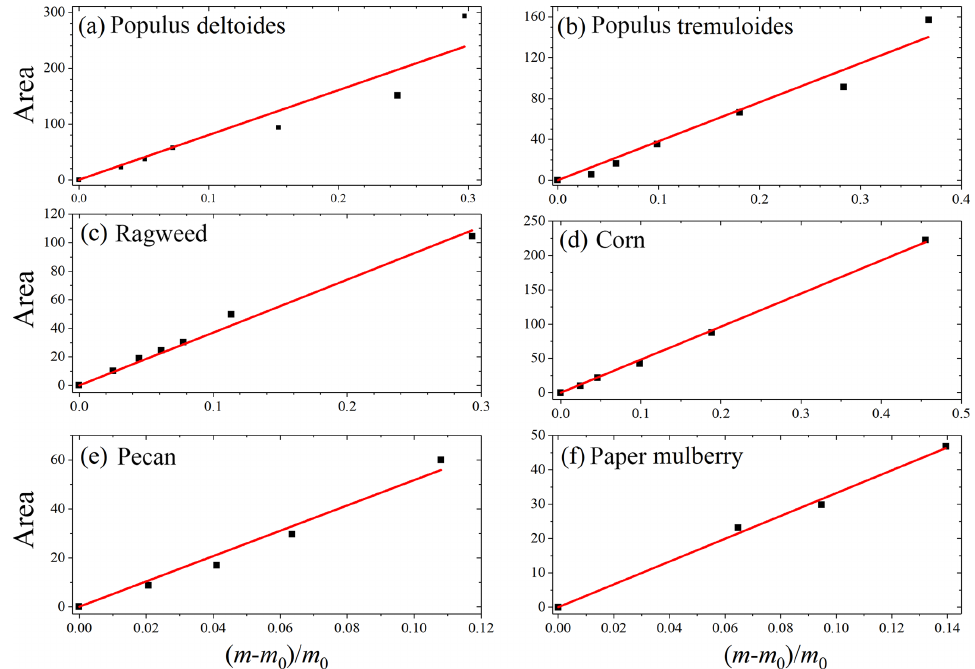
Figure 6. Integrated areas of IR peaks at ∼ 3600cm − 1 vs. relative mass increase due to water uptake, ( m − m 0 )/m 0 , for six pollen species: (a) Populus deltoides , (b) Populus tremuloides , (c) ragweed, (d) corn, (e) pecan and (f) paper